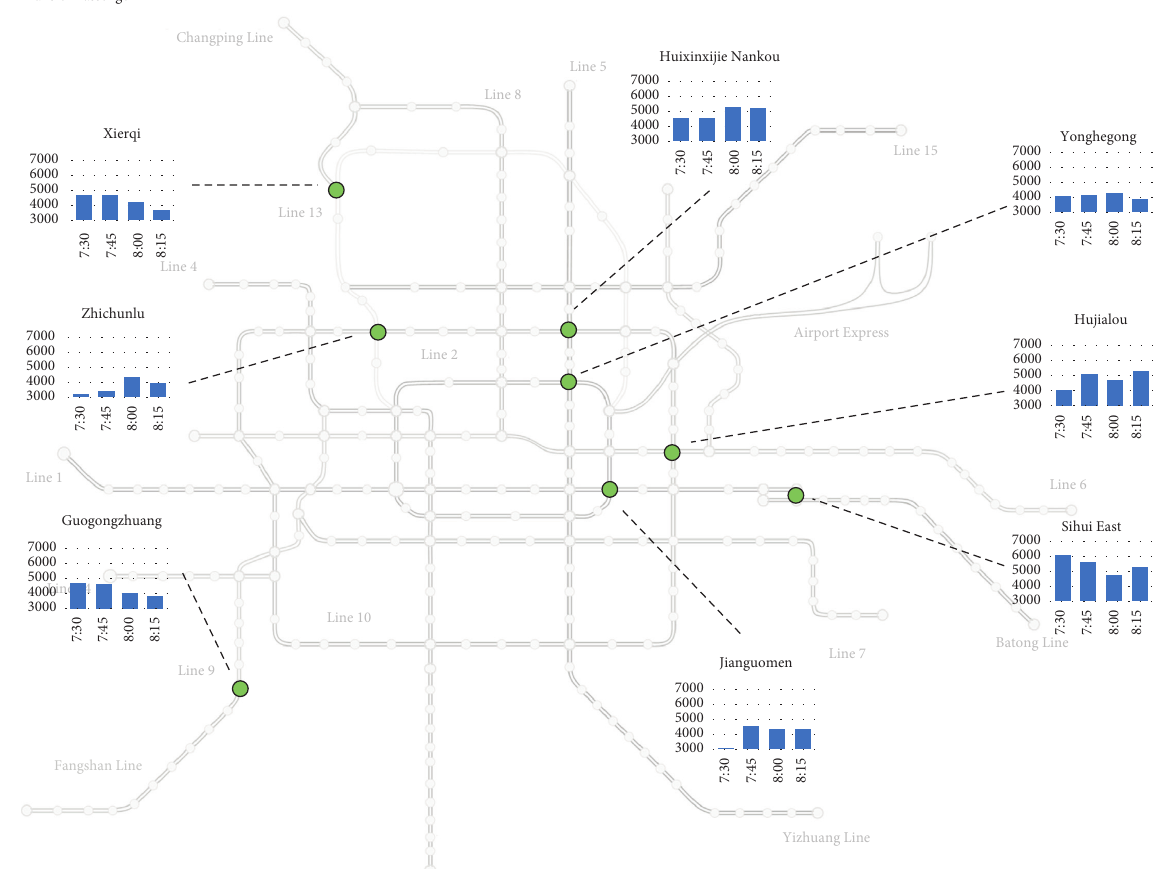
Figure 7: Locations of top eight transfer stations during the peak hours in the